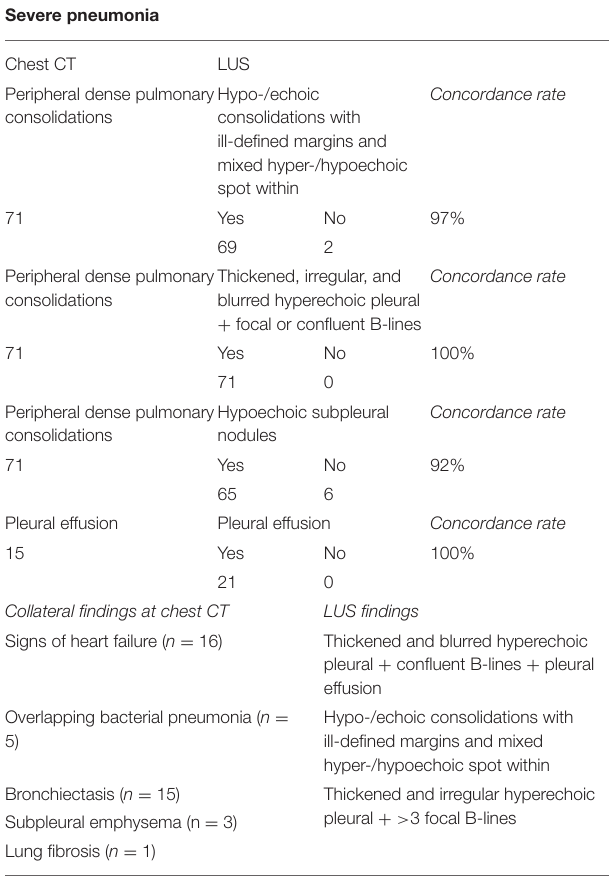
TABLE 6 | Concordance rate between LUS and CT scan in patients with a CT scan negative for COVID-19 lung